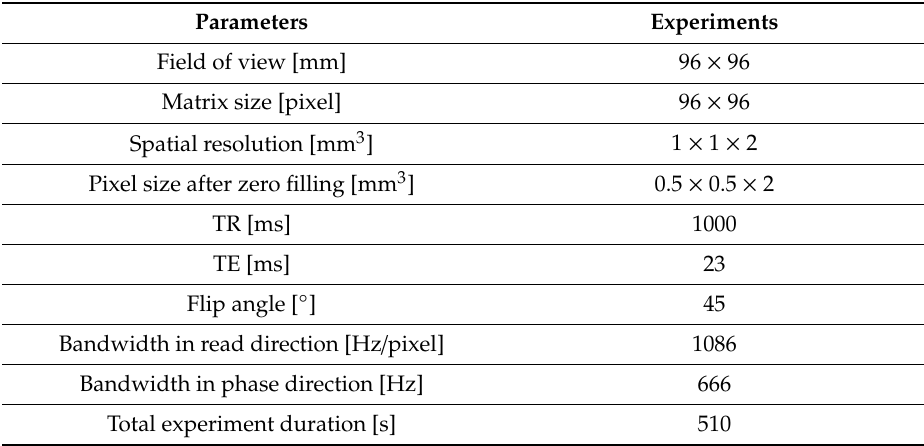
Table 1. GRE-EPI sequence parameters used for MRTI during laser ablation on agar gel.